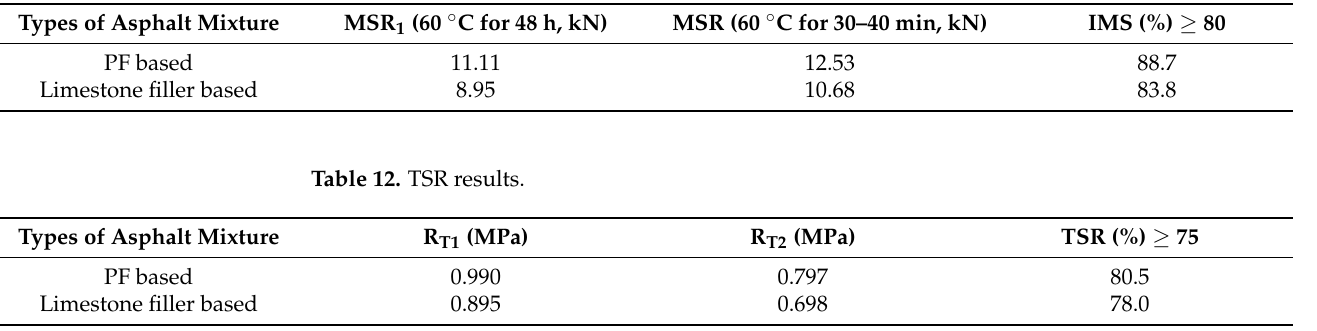
Table 11. IMS results.